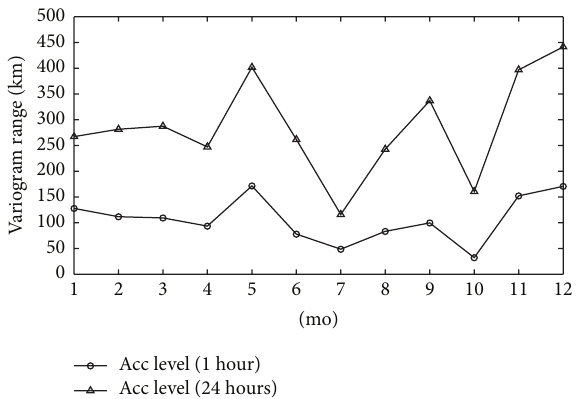
Figure 14: Characteristic scale of climate change reflected upon precipitation linear trend in Korean Peninsula.